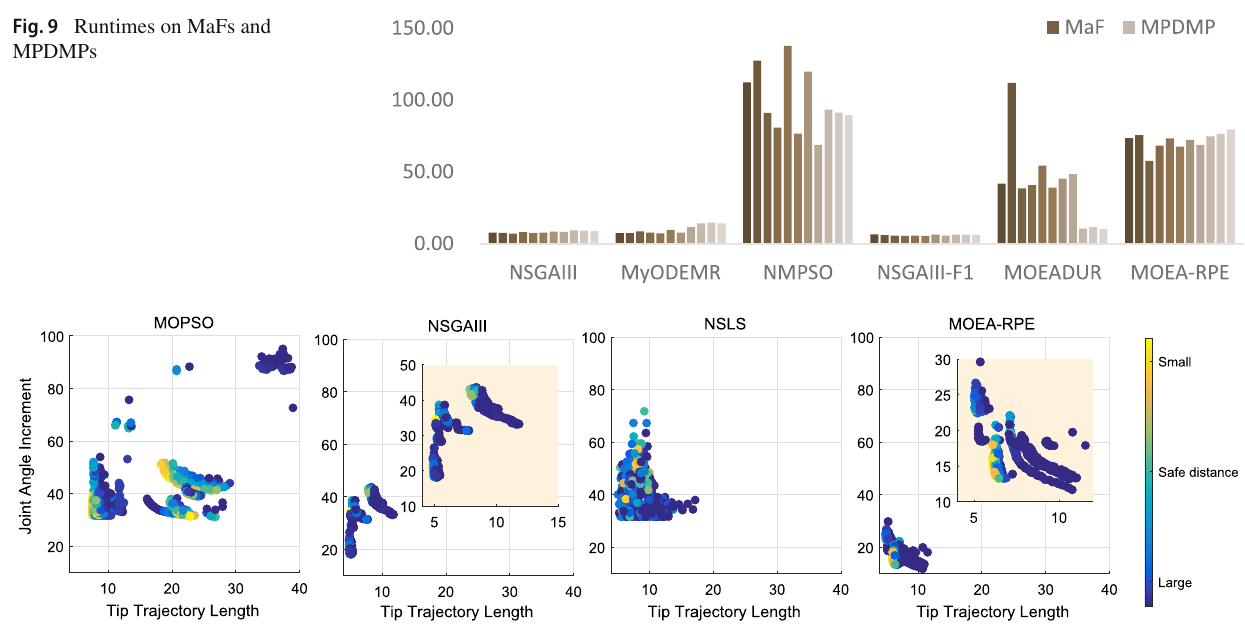
Fig. 10 The performance of robotic manipulation path planning optimization problem effectiveness and parameter sensitivity, and a recommended range for the robust solution proportion has been